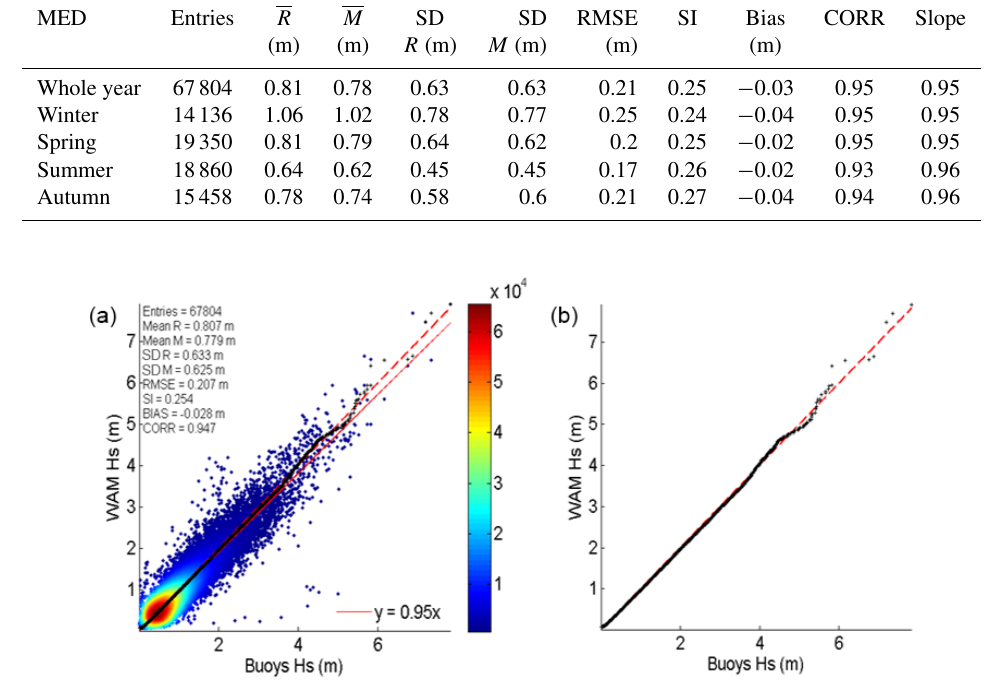
Figure 4. QQ–scatter plots (a) and QQ plot alone (b) of Med-waves output H s versus wave buoy observations, for the full Mediterranean Sea, for a 1-year period (2014): QQ plot (black crosses), 45 ◦ reference line (dashed red line), least-squares best-fit line (red line, a